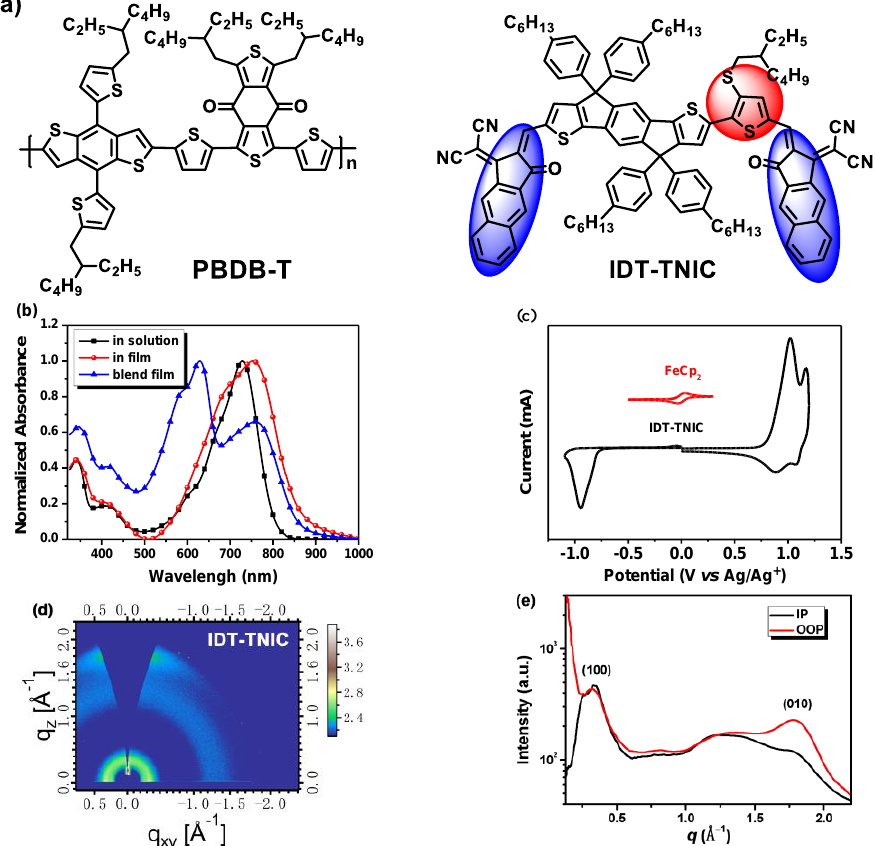
Figure 1. ( a ) Chemical structures of PBDT-T and IDT-TNIC, ( b ) absorption spectra of IDT-TNIC in solution, solid film and PBDT-T:IDT-TNIC blend films, ( c ) cyclic voltammogram of IDT-TNIC, ( d ) the two-dimensional GIWAXS patterns of IDT-TNIC pure film, ( e ) the corresponding in-plane and out-of-plane profiles under optimal condition.